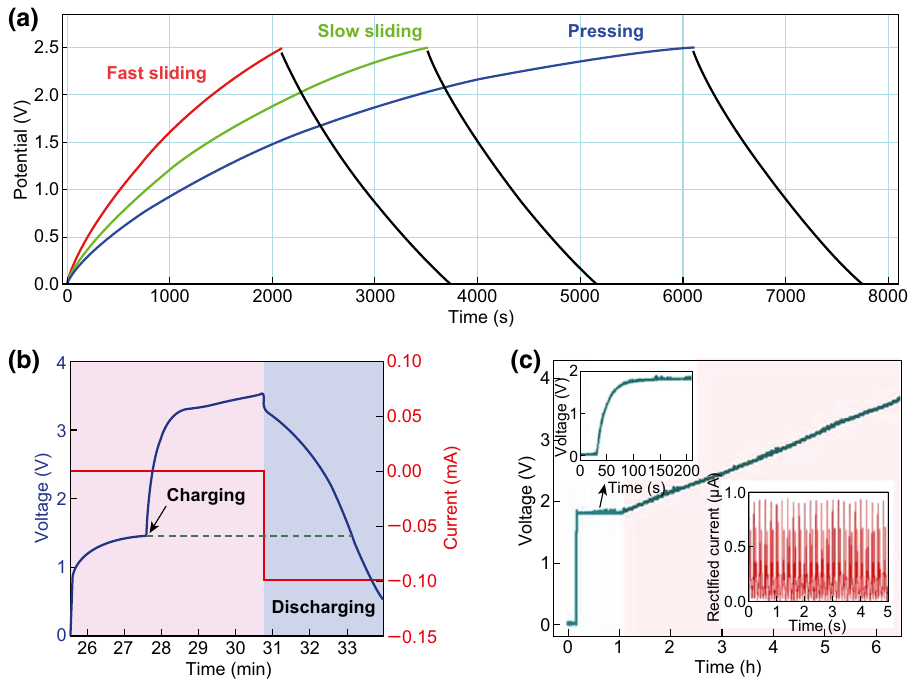
Fig. 11 a Charging curves of four TFSCs in series charged by the TF‑TENG at fast sliding, slow sliding, and pressing. Reprinted with permis‑ sion from Ref. [18]. b Self‑charging and discharging curves of the top Li‑ion battery. Reprinted with permission from Ref. [19]. c Charging curve of the F‑DSSC and the F‑TENG, where the light blue‑shaded area corresponds to the charging curve of the F‑DSSC and the light red‑ shaded area corresponds to the charging curve of the F‑DSSC–F‑TENG hybrid. Reprinted with permission from Ref.